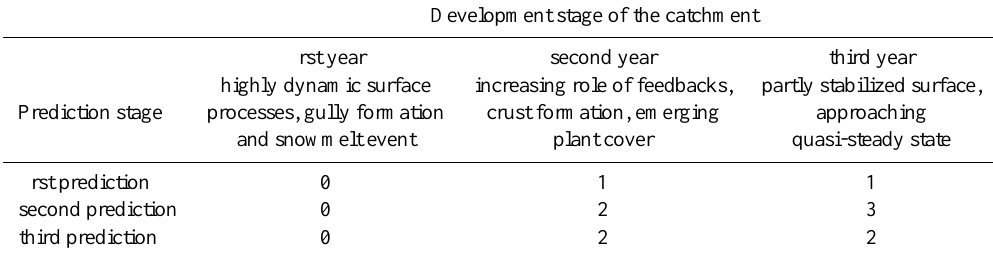
Table 11. Rating of prediction progress compared to measurements in the course of consecutive model improvements (0=poor to 3=good). Development stage of the catchment highly dynamic surface Prediction stage processes, gully formation crust formation, emerging